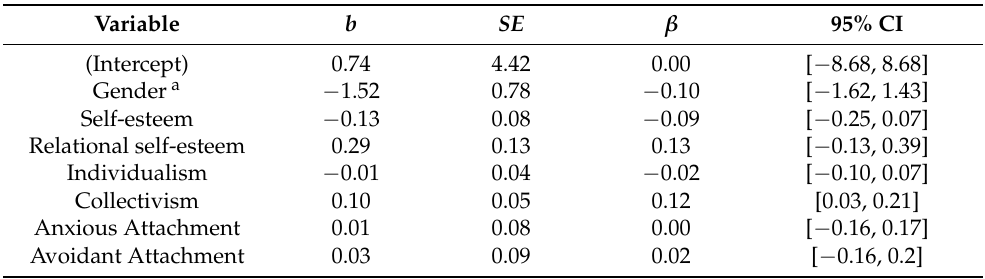
Table 3. Regression Coefficients of Study Variables on External—Spiritual Locus-of-Hope.